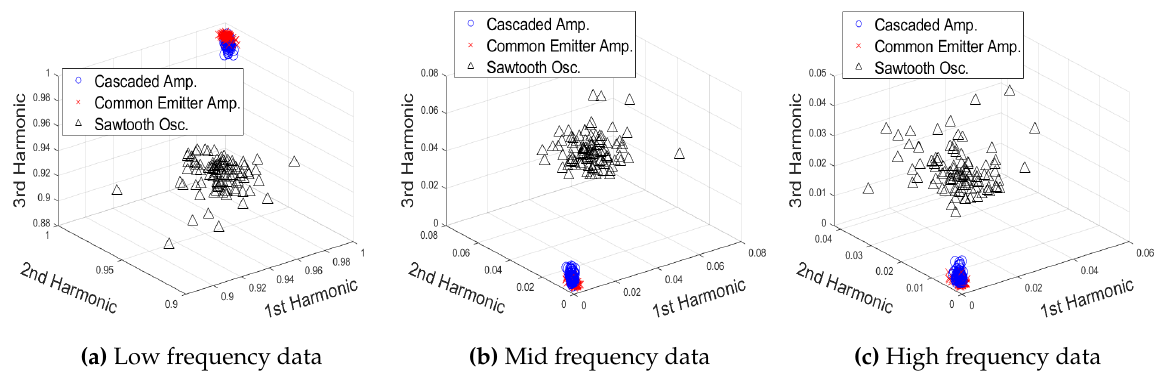
Figure 13. Scattered plots of Fourier features in 3D harmonic space, SNR=14 dB. Figure 13. Scatter plots of Fourier features in 3D harmonic space, SNR = 14 dB. Table 4. Confusion matrices for Fourier features in first, second, and third harmonic spaces for SNR = 8 Table 4. Confusion matrices for Fourier features in first, second and third harmonic space for SNR=8 dB.